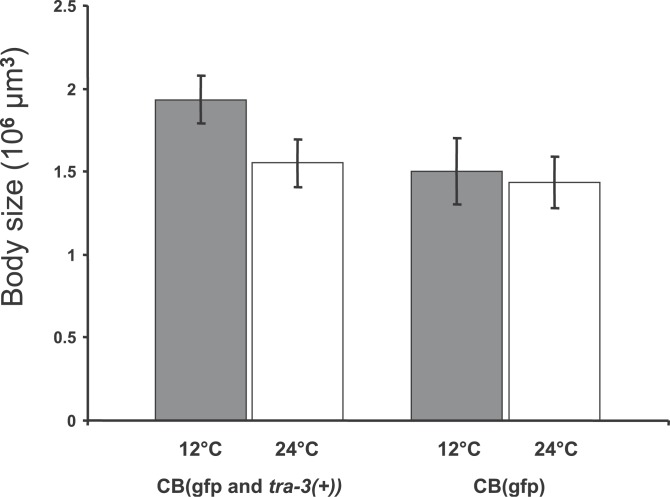
The tra-3 N2 Allele Makes CB Grow Larger at Low TemperatureWe measured body size in transgenic CB strains carrying the N2 allele of tra-3. Average values are shown for four to five independently derived strains of CB(gfp and tra-3(+)) and CB(gfp). The transgenic strains grew significantly larger at low temperature (t-test, n = 39, p < 0.0001). Bars are standard deviation.